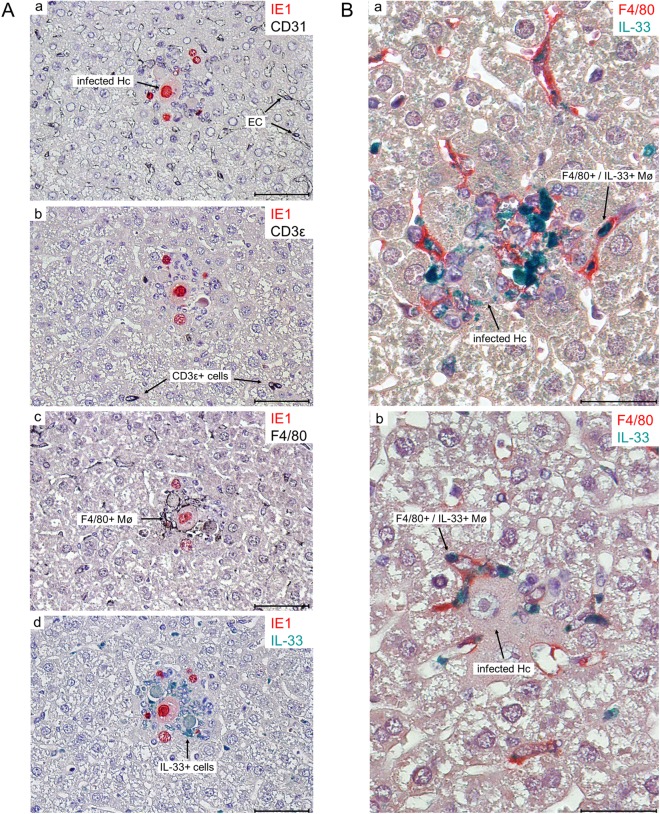
Identification of the cell type that expresses IL-33 in inflammatory foci in infected liver tissue as F4/80+ macrophages.BALB/c mice were injected i.v. with 5x105 PFU of WT MCMV (MW97.01) and liver tissue was harvested on day 5 p.i. (A) Consecutive serial 1-μm sections of liver tissue focusing on an infected hepatocyte (Hc) that is delimited from uninfected tissue by a sheath made up by a mononuclear cell infiltrate. The expression of the indicated marker molecules was tested in a two-color IHC (2C-IHC) staining. (a-d) Identification of the infected Hc by red staining of the intranuclear viral IE1 protein. (a) Focus-forming mononuclear cells are not CD31+ black-stained endothelial cells (EC). (b) Focus-forming mononuclear cells are not CD3ε+ black-stained cells, thus excluding α/ß and γ/δ T cells as well as NKT cells. (c) Identification of focus-forming mononuclear cells as black-stained F4/80+ macrophages (Mø). (d) IL33-expressing cells stained in turquoise-green color colocalize with focus-forming F4/80 macrophages in the neighboring section of image c. Counterstaining with hematoxylin. Arrows point to the indicated cell types exemplarily. The bar markers represent 50 μm throughout. (B) 2C-IHC verifying colocalization of F4/80 and IL33 on the cellular level. (a) Higher resolution image of an advanced, aged focus consisting of a cluster of dual-stained F4/80+ (red) IL33+ (turquoise-green) macrophages (Mø) surrounding an infected hepatocyte (Hc) that is identified by an intranuclear inclusion body. Note that dually-expressing macrophages localize also to liver tissue outside of a focus. (b) A young focus in which dual-stained F4/80+ (red) IL33+ (turquoise-green) macrophages cling to an infected hepatocyte (Hc) that shows the pathocytomorphology of an owl’s eye cell with an intranuclear inclusion body that indicates the late phase (L phase) in the viral gene expression program. Counterstaining with hematoxylin. Arrows point to sites of interest. The bar markers represent 50 μm.